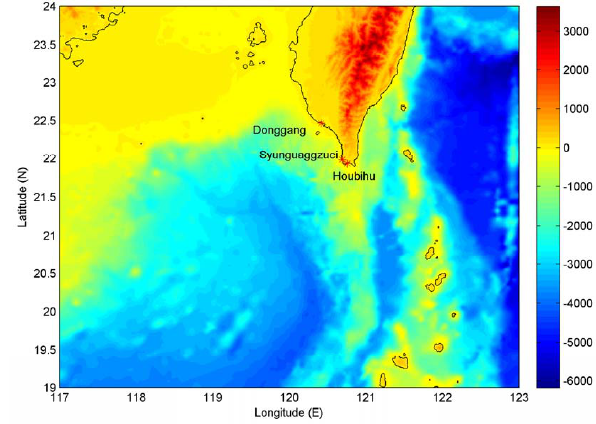
Figure 3. Gauge location and bathymetry profile used in the performance test of SUTIM. 2 Fig. 3. Gauge location and bathymetry profile used in the perfor- mance test of